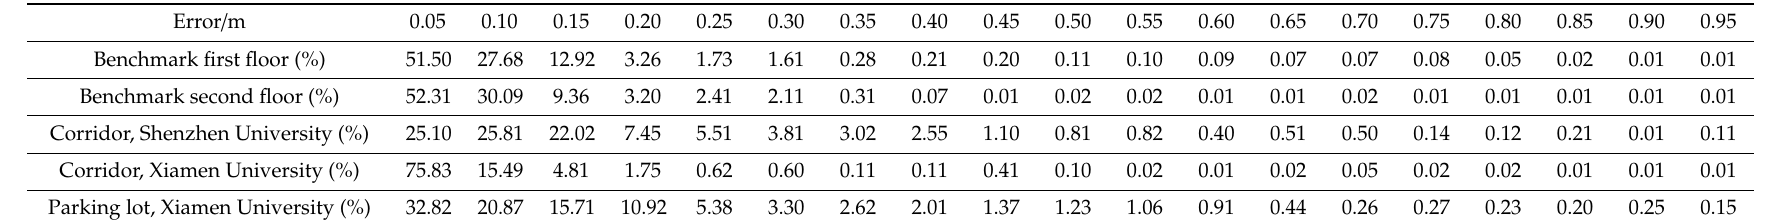
Table 6. Euclidean distance deviation for di ff erent